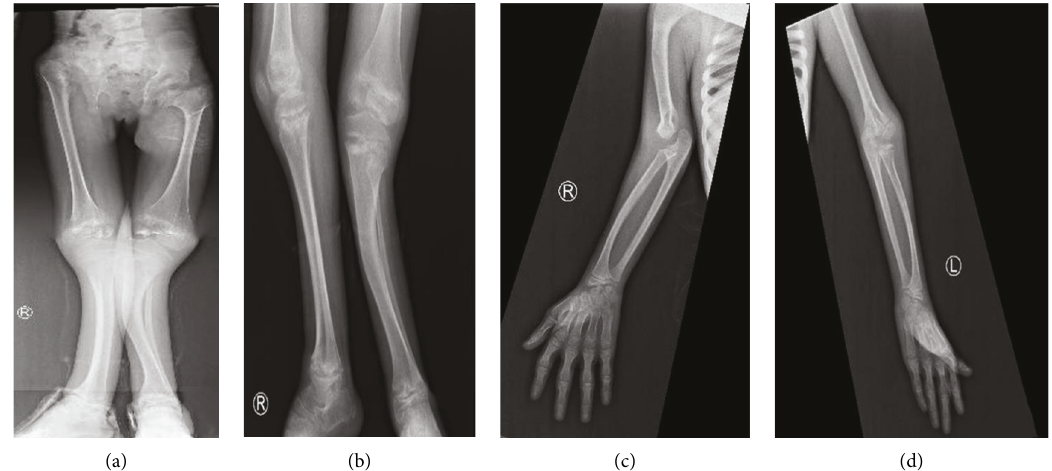
Figure 2: Radiographies. (A, B) Diffuse osteopenia and tubular bones are short. Metaphyseal sclerosis and irregularities more pronounced in and sclerotic femoral heads. Right hip dislocation with external the lower limbs. (C, D) Right humerus bowing deformity. Small, fragmented rotation of the right lower limb. Bilateral coxa varus. Left genu valgus. Bowing deformity of the left tibia. Metacarpals and metatarsal are short.